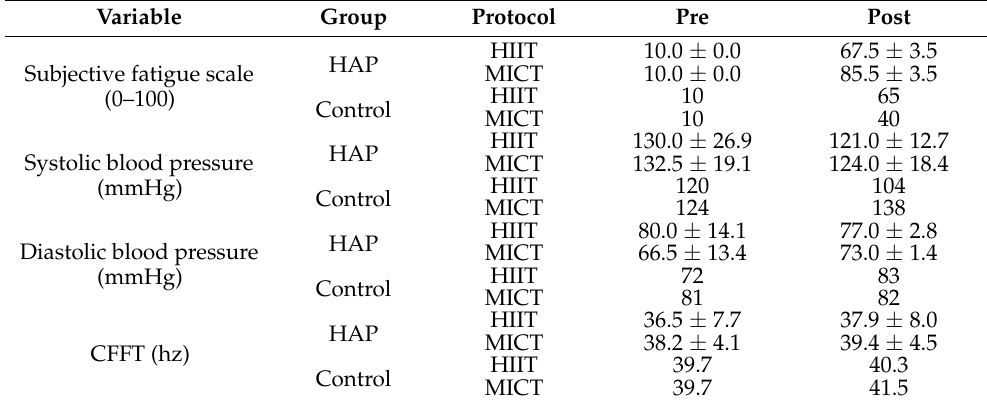
Table 4. Fatigue of central nervous system, blood pressure and cortical arousal variables in heart attack patients and control in high-intensity interval training and moderate-intensity continuous training. Variable Group Protocol Pre